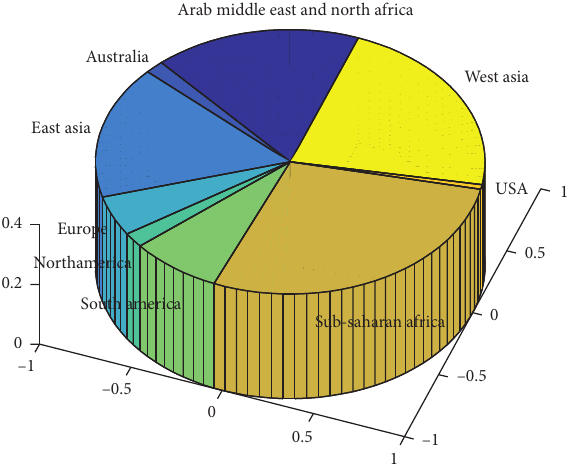
Figure 9: Overall regional distribution (2005–2017) (No. 2).